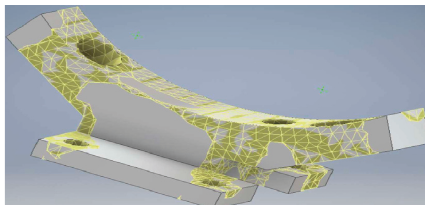
Figure 11: 3D solid compliant robotic gripper.